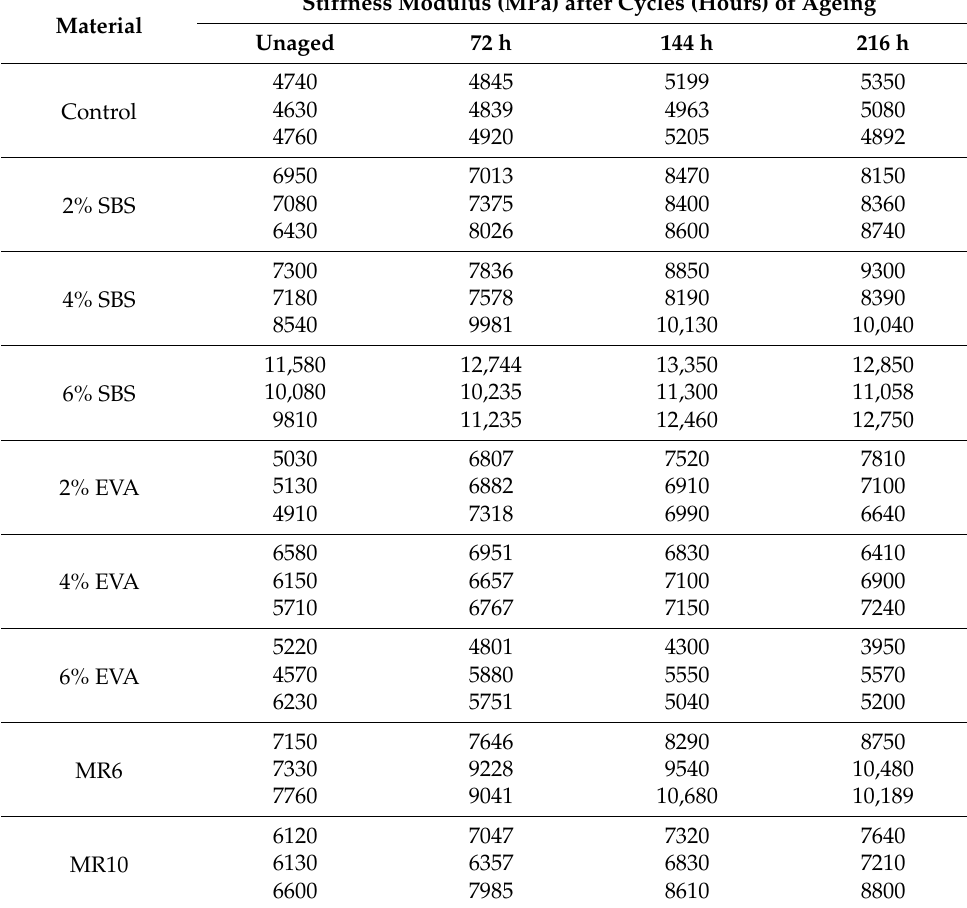
Table 5. Asphalt mixture stiffness modulus